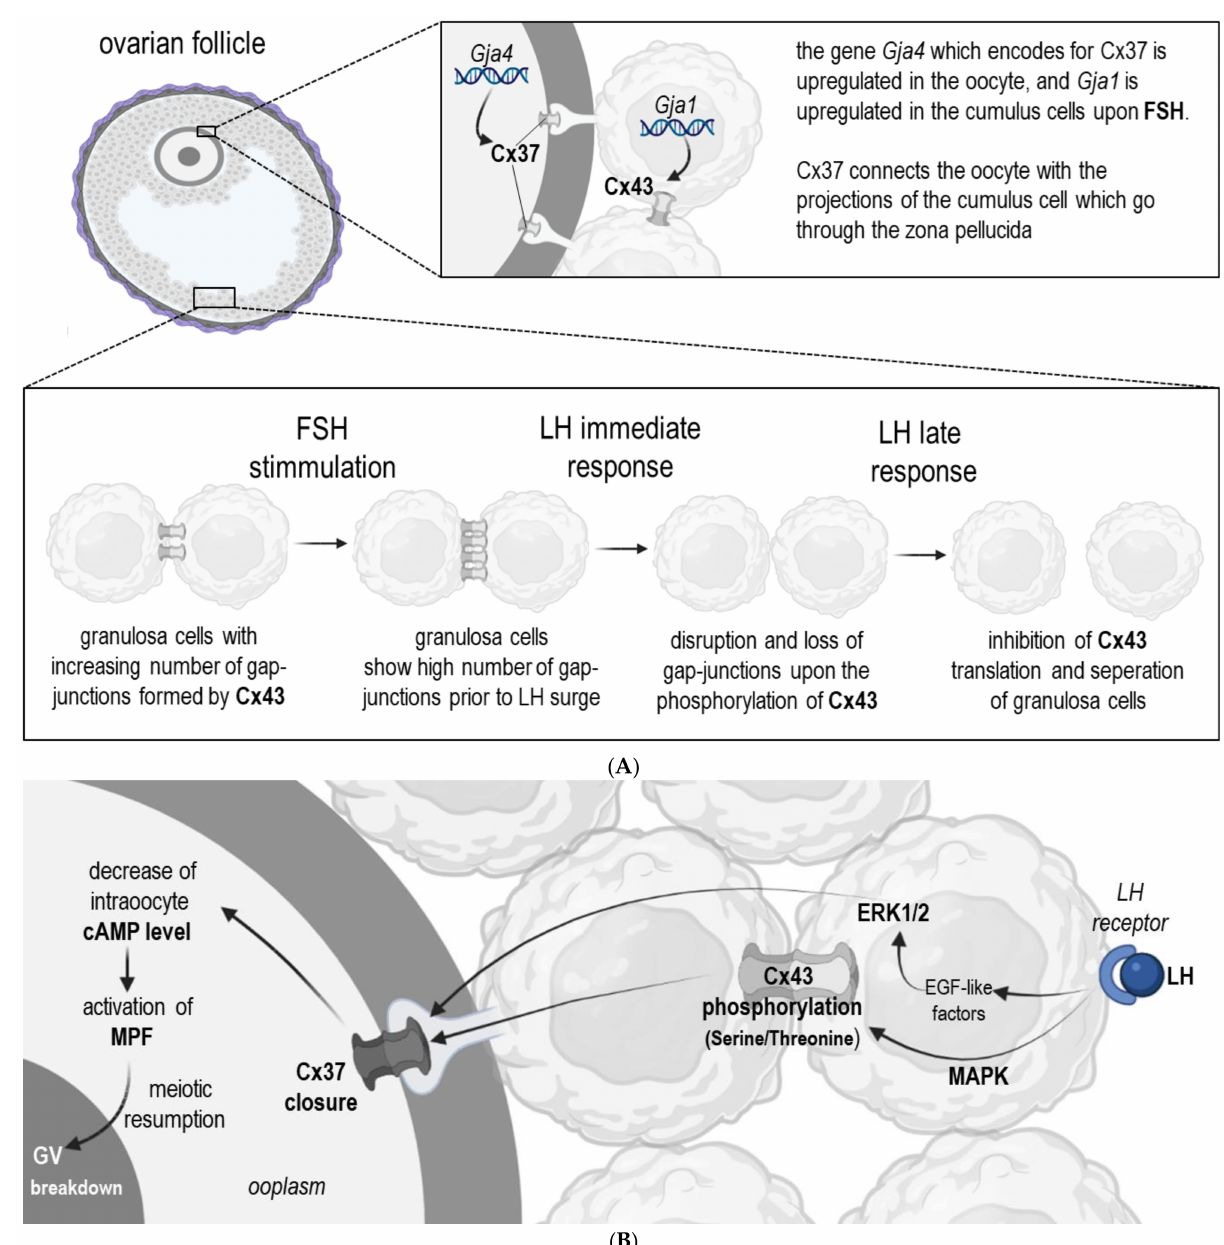
Figure 2. Scheme showing the regulation of gap-junctional communication (Cx43, Cx37) during the development of antral follicles prior to ovulation ( A ) and during meiotic resumption ( B ). ( A ) FSH hormone stimulates mRNA expression that codifies the Cx43/Cx37 synthesis of the gap-junctions, the amplification of functional channels, and consequently the integration to the metabolic activity. Mediated by the family mitogen-activated protein kinases, pre-ovulatory LH levels interrupt cell-cell communications by means of phosphorylation and modification of Cx43 protein conformation. This leads to interruption of the intercellular channels. The primary effect of the immediate response to LH is accompanied by elimination of the Cx43 protein, disappearance of gap-junction separation of the GCs from the oocyte. ( B ) LH stimulates the MAPK-dependent phosphorylation of Cx43, which induces the closure of Cx37and a decrease of cAMP inside the oocyte. In consequence, the maturation promoting factor (MPF) is activated and leads to resumption of meiosis and germinal vesicle (GV) breakdown. Abbreviations: Cx = Connexin, FSH = follicle stimulating Hormone, GJA = gene en-coding for connexins, LH = luteinizing hormone, ERK1/2 = extracellular signal-regulated kinases 1 and 2, MAPK = mitogen activated protein kinase, EGF = epidermal growth